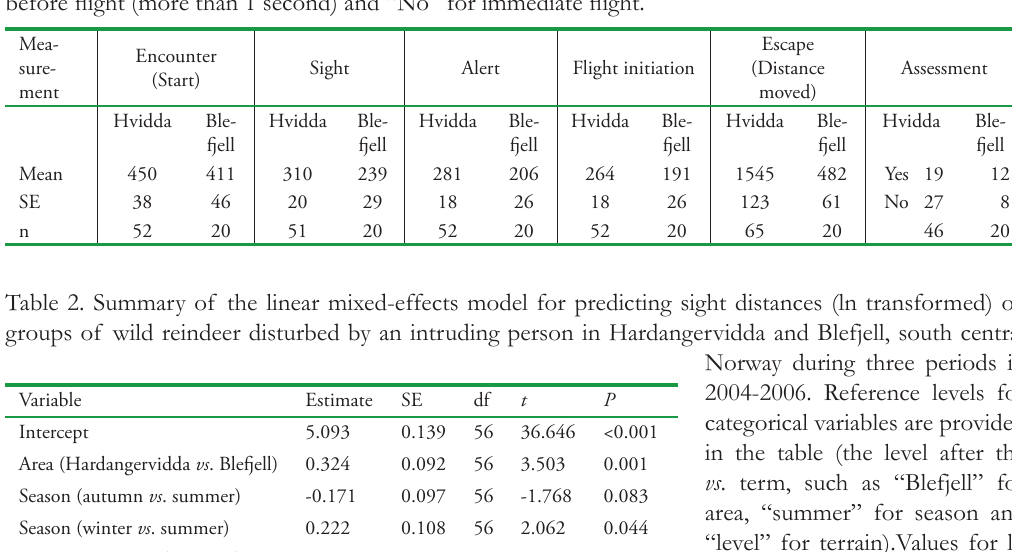
Table 1. Untransformed response distances ± SE of wild reindeer disturbed by an intruding person in Blefjell and Hardangervidda (Hvidda) wild reindeer areas. All responses are distances measured in meters. The exception is assessment which is a binomial factor with “Yes” if the group was assessing the observer before flight (more than 1 second) and “No” for immediate flight.